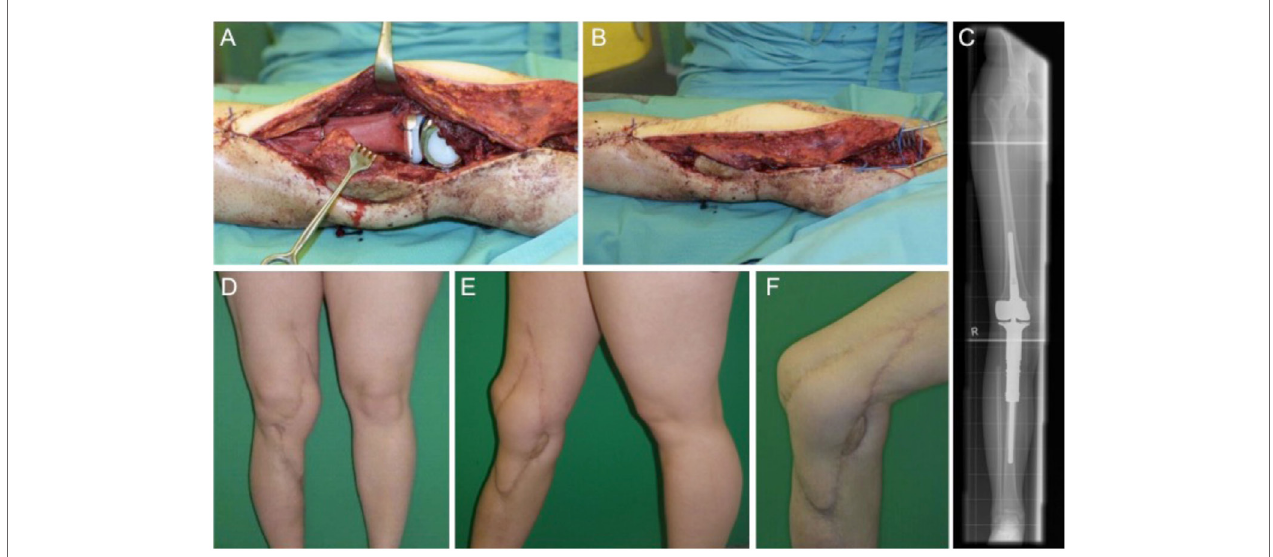
FiGURe 3 | intraoperative situs with implanted tumor prosthesis (MUTARS ® ) after extraarticular tumor resection of the knee joint (A,B) and coverage with a microvascular latissimus dorsi flap (B) . (C) shows the corresponding x-ray image with a proximal tibial replacement. Post-operative esthetic and functional outcome (D–F)